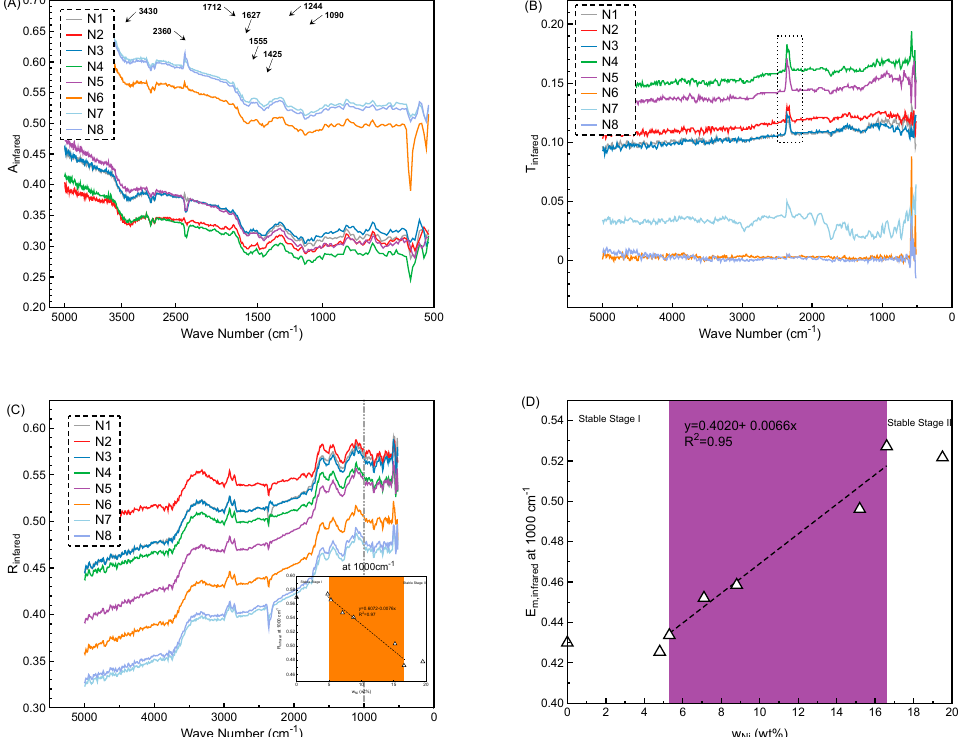
Figure 11. Analysis of infrared resistance of Cu/Ni-coated Milife Fabric ( A ) absorptance curves; ( B ) transmittance curves; ( C ) reflectance curves incorporated with the relationship between w Ni and R infrared at 10 µ m; ( D ): relationship between w Ni and E m,infrared. Table 6. Evaluation of infrared resistance of Cu/Ni-coated Milife Fabric at 1000 (cm − 1 ). Sample Code R infrared